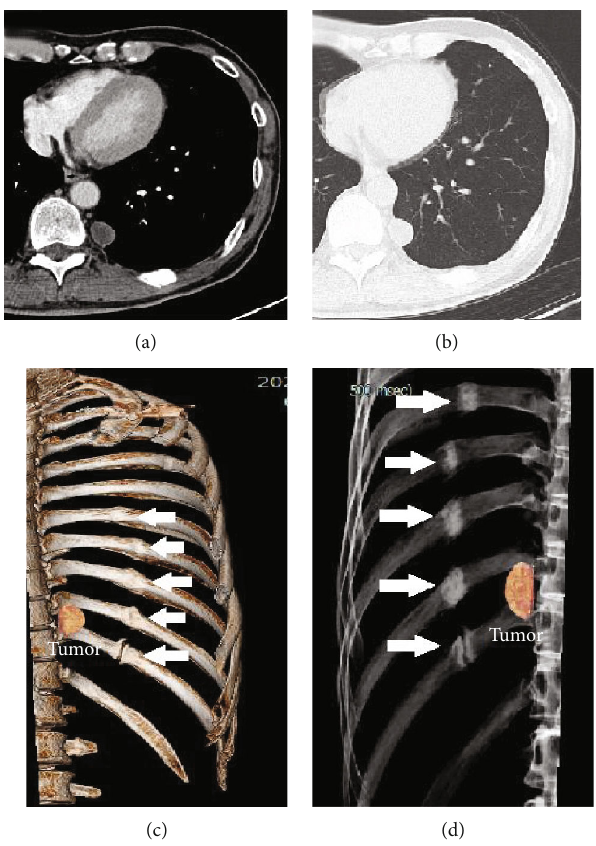
Figure 1: (a) Axial CT enhanced with intravenous contrast, mediastinal window. (b) Axial CT, pulmonary window. (c, d) Three-dimensional reconstruction using the CT of the chest (right ribs removed). Paraspinal oval mass in the lower thoracic spine measuring 20 mm in diameter. The capsule enhances slightly with contrast. The tumor is well-circumscribed without intraspinal extension. The callus formations in the posterior ribs (7th to 11th) can be observed, suggesting previous rib fractures (c, d; arrowheads).